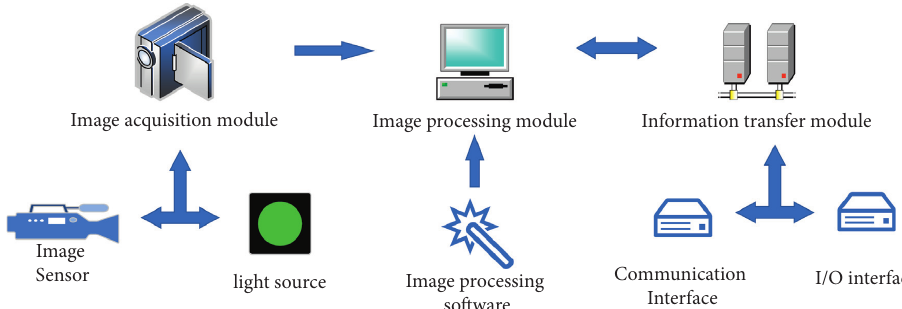
Figure 4: Composition of the visual sensor